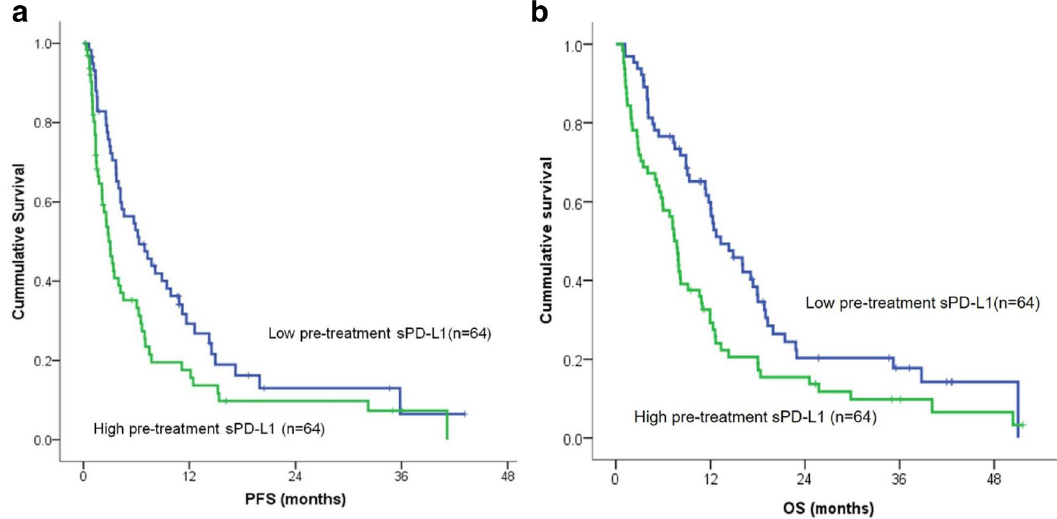
Figure 1. Kaplan–Meier curves for progression-free survival ( a ) and overall survival ( b ) stratified by soluble programmed death ligand 1 level. PFS progression-free survival, OS overall